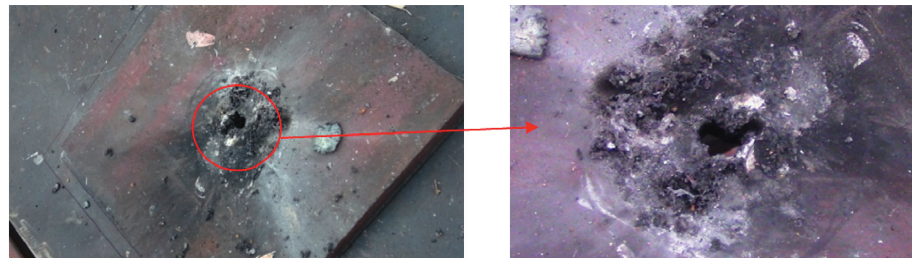
Figure 16: Experimental result of penetrating 25mm